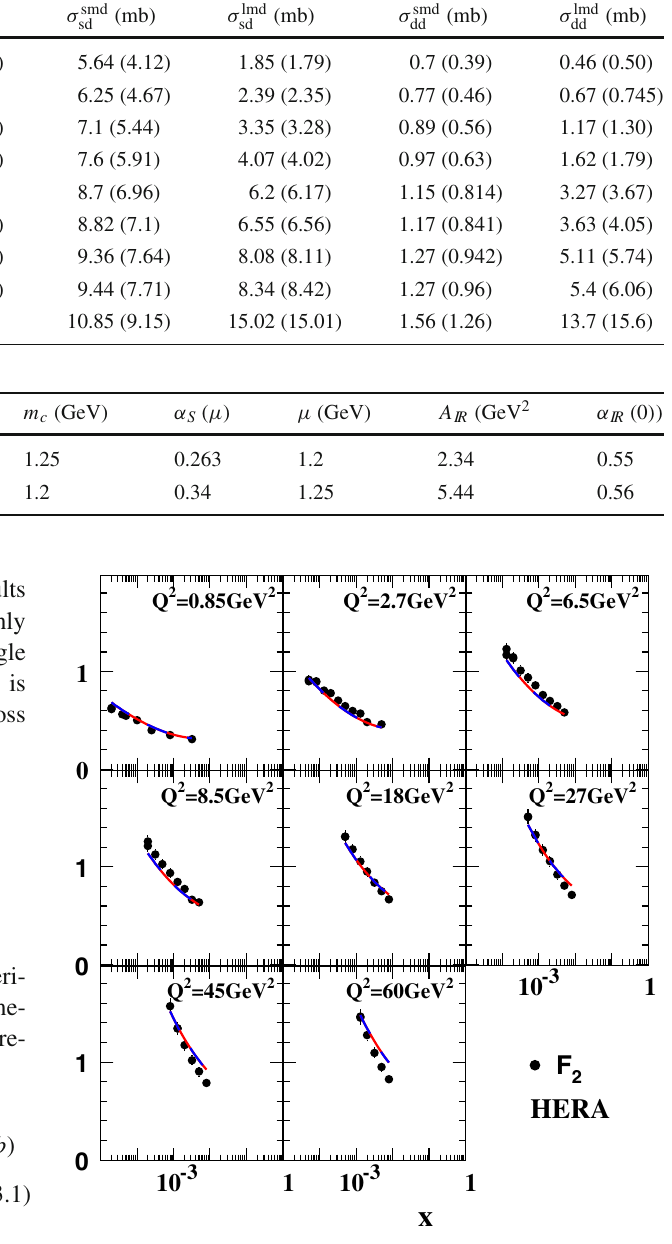
Fig. 2 F 2 versus x at fixed Q . The red curve corresponds to fit I, while the blue one describes fit II. Data is taken from Refs. [51,52]